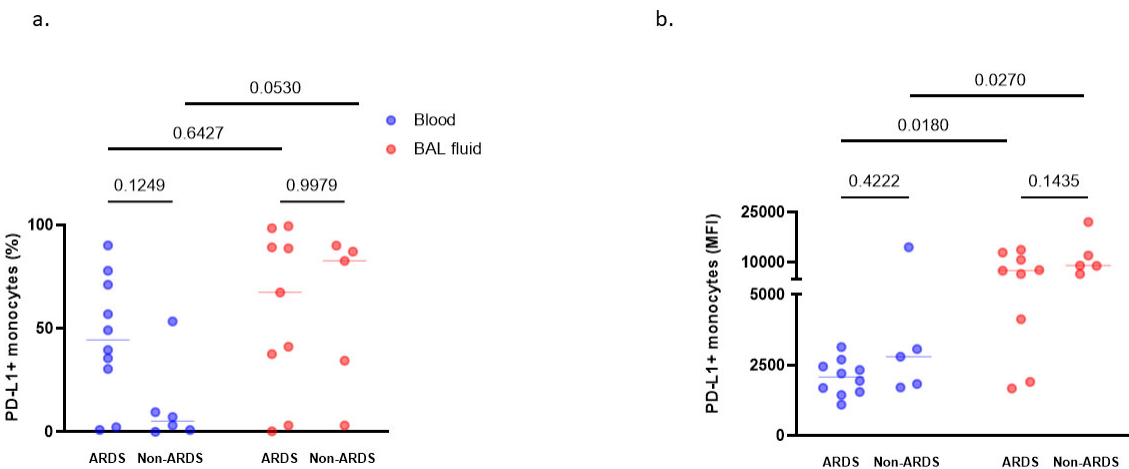
Figure 4. PD-L1 expression on monocytes in broncho-alveolar lavage fluid and blood of pneumonia-related ARDS ( n = 9) and non-ARDS patients ( n = 5, anti-PD-L1 antibodies were missing for three experiments). Expression of PD-L1 on monocytes was quantified in percentage of positive cells ( a ) or in mean fluorescence intensity (MFI) ( b ) in standard conditions (medium). By two-way ANOVA with repeated measures, there was a significant effect of group (ARDS vs. non-ARDS, p = 0.0490) but no significant effect of compartment (BAL fluid vs. blood, p = 0.2484), nor effect of interaction (group x compartment, p = 0.2461), when expressed in percentage of positive cells ( a ). When results were expressed in MFI ( b ), there was a significant effect of group (ARDS vs. non-ARDS patients, p = 0.0010), also a significant effect of sample compartment (BAL fluid vs. blood, p = 0.0192), without significant interaction (group x compartment, p = 0.6032). Displayed p -values come from post-hoc comparisons performed using the Sidak’s test. Horizontal bars represent median values.